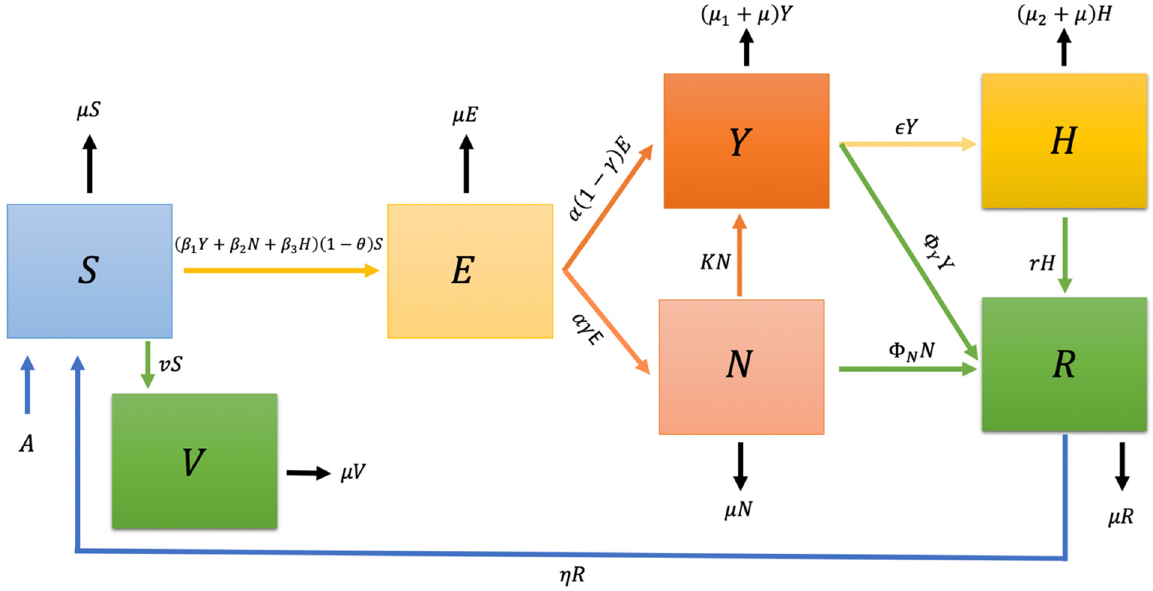
Figure 1. Schematic diagram of the compartmental epidemic model presented in Equation (1).